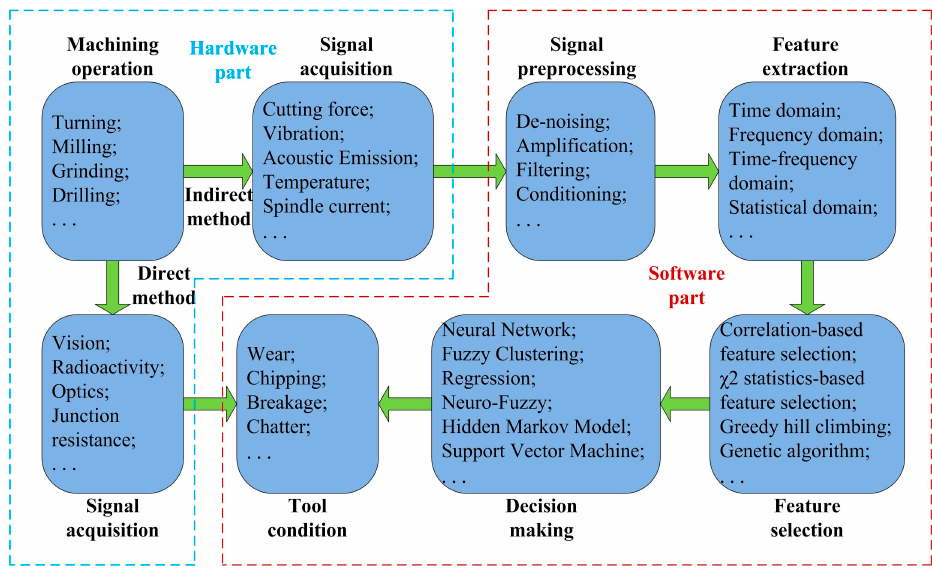
Figure 1. The framework of a Tool Condition Monitoring (TCM) system.